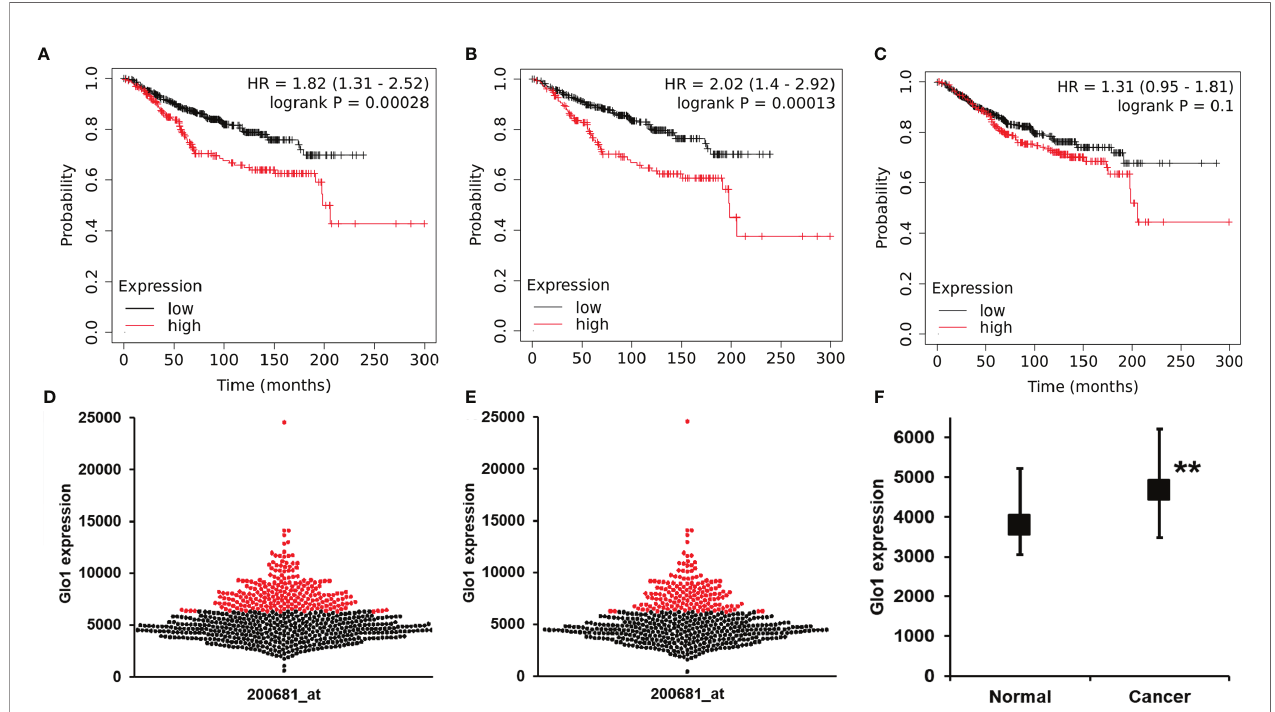
FIGURE 5 | Glyoxalase 1 expression is a negative survival factor in clinical human breast cancer with chemotherapy treatment. Association of baseline Glo1 expression with overall survival in patients with breast cancer treated with chemotherapy (from the KM Plotter database). Glo1 expression in breast cancers of all genotypes: (A) Kapan-Meier survival analysis and (D) butter fl y plot of breast cancers of low (black dots) and high (red dots) Glo1 expression ( n = 683). Glo1 expression in patients with HER2-negative tumors: (B) Kapan-Meier survival analysis and (E) butter fl y plot of breast cancers of low (black dots) and high (red dots) Glo1 expression ( n = 531). (C) Kapan-Meier survival analysis for Glo2 expression in breast cancers of all genotypes ( n = 683). (F) Glo1 expression in normal breast tissue and breast cancers. Data are median (lower – upper quartile); normal, n = 3778, cancer, n = 4667. Signi fi cance: **P < 0.01; Mann-Whitney U test. For the low and high gene expression cutoff, the “ Autoselect best cutoff ” feature in the KM Plotter was used. This computes survival outcomes for all possible cutoff values between lower and upper quartiles of Glo1 expression and selects the cutoff for FDR below the threshold value (0.05) and minimum p -value